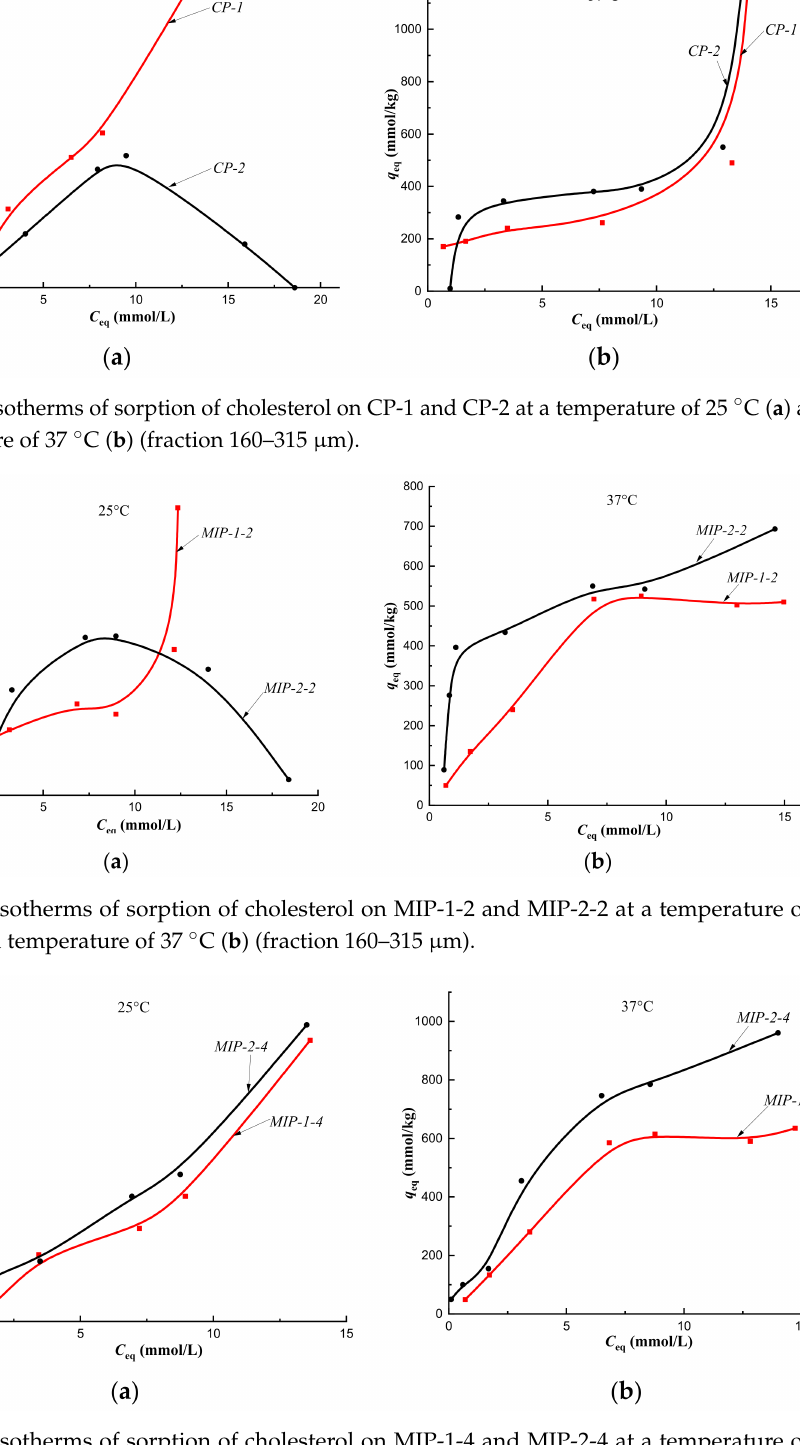
Figure 9. Isotherms of sorption of cholesterol on MIP-1-4 and MIP-2-4 at a temperature of 25 ◦ C ( a ) and at a temperature of 37 ◦ C ( b ) (fraction 160–315 µ